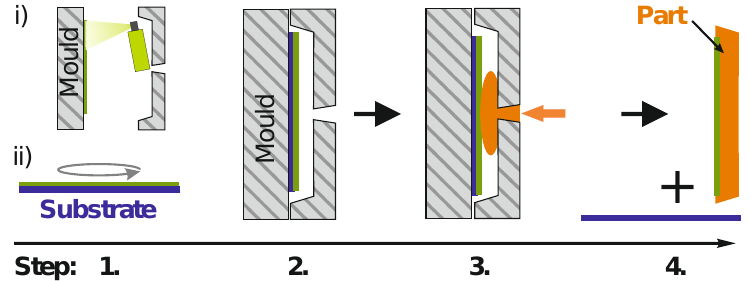
Figure 1. Processing steps of surface modification during molding. 1. Formation of thin film (10–100 nm) of modifier by either ( i ) spray-coating or ( ii ) spin-coating; 2. Modifier layer on mounted substrate or directly on mold surface; 3. Injection of the polyether ether ketone (PEEK) melt while initiating a coupling reaction, see also graphical abstract figure; 4. Demolding with transfer of the modifier layer to the